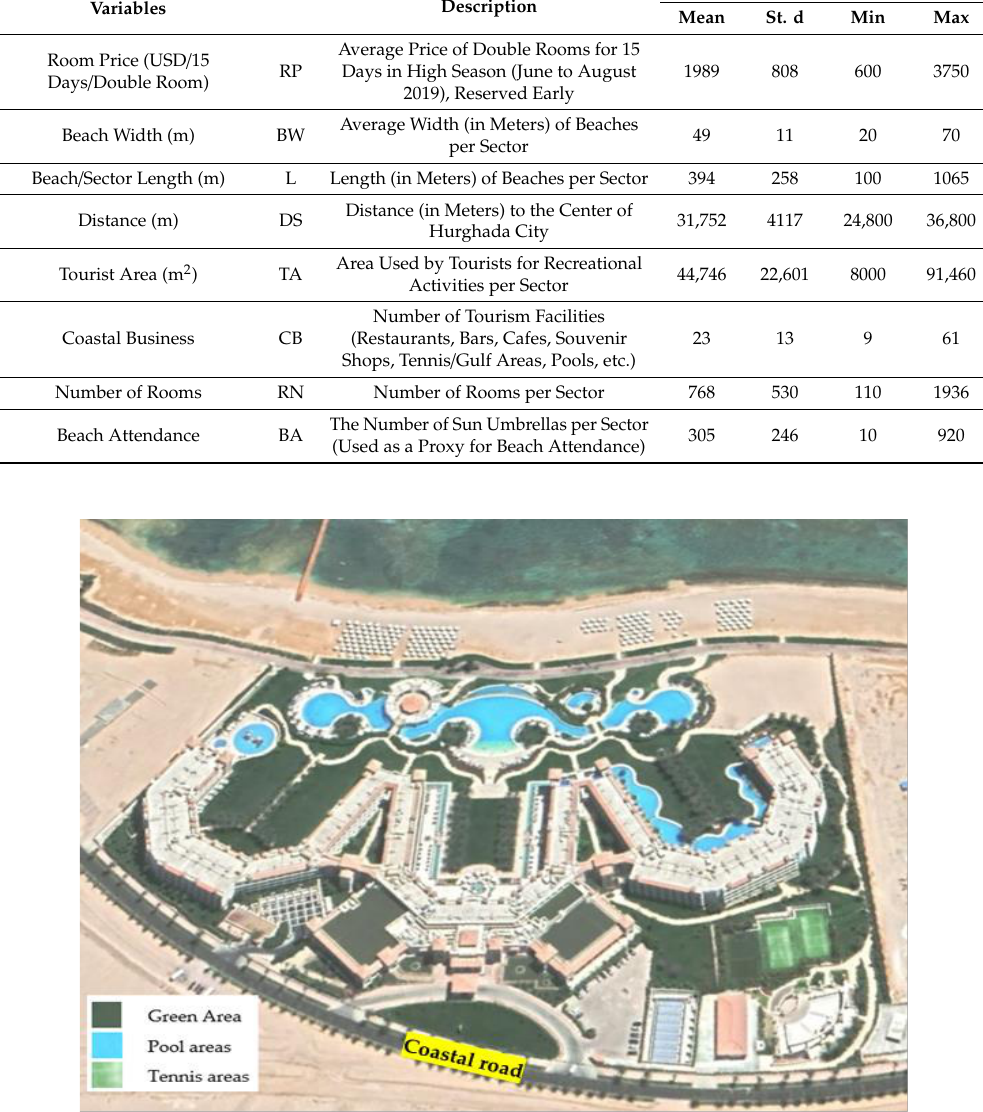
Figure 3. An example for the tourist area (satellite image resort number 5).